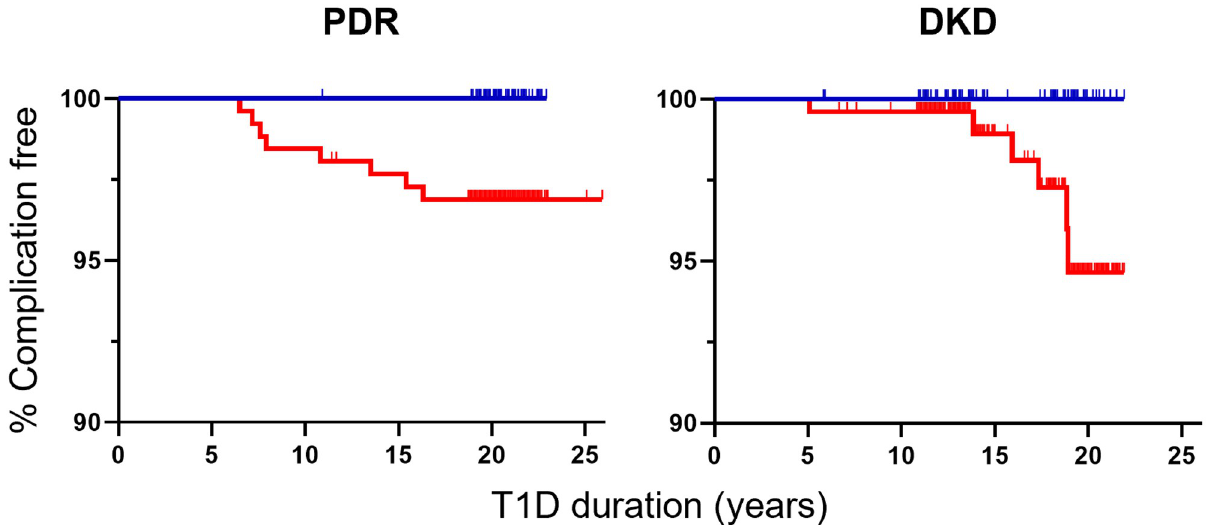
Fig 1. Association between INS variation and complication probability during intensive insulin treatment. The complication free probability of PDR (left) and DKD (right) is shown for type 1 diabetes patients carrying the protective (blue) and susceptible (red) INS variant in the primary prevention group of the DCCT/EDIC intensively treated study arm. None of the individuals carrying the protective INS variant developed PDR or DKD (0 of 67 and 0 of 67, respectively); however, PDR and DKD occurred in those carrying the susceptible INS variant (8 of 258 and 6 of 258, respectively). Homozygous and heterozygous protective patients were combined due to low numbers of protective homozygotes.